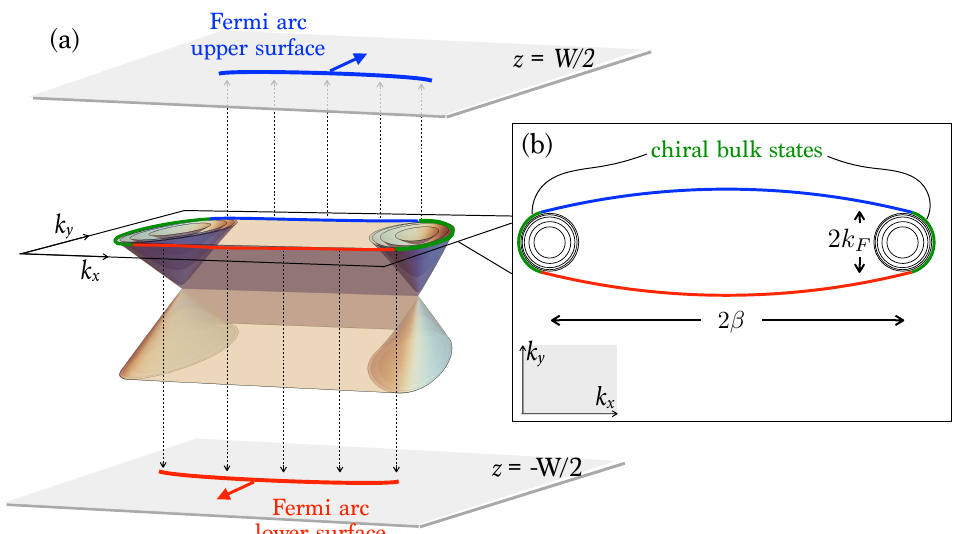
Figure 1: (a) Schematic picture of the considered Weyl-slab model in a mixed momentum- / real-space illustration. The plot shows the slab spectrum as a func- tion of in-plane momenta. Top (blue) and bottom (red) surface states are indicated with their position and propagation direction in real space. Chiral bulk states connect- ing surface states of both surfaces are depicted in green. (b) Top-view on equi-energy contours of the slab spectrum of